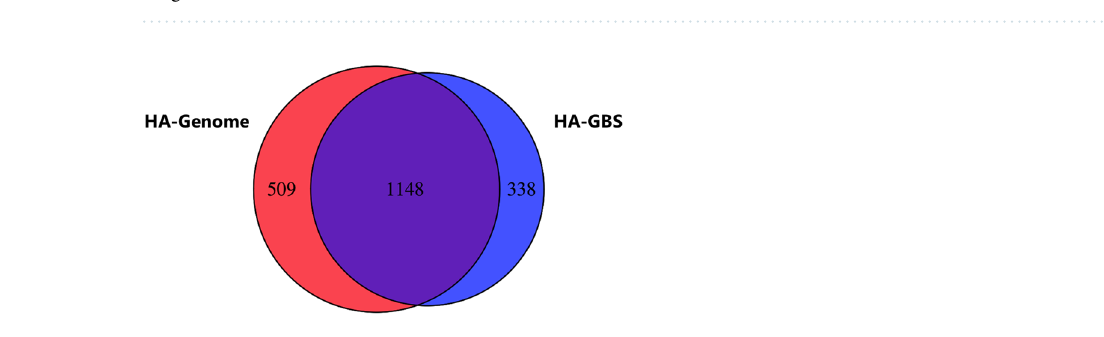
Figure 5. Venn diagram showing the number of scaffolds from the fragmented seashore paspalum reference genome assembly that were anchored to the HA Genome and HA GBS